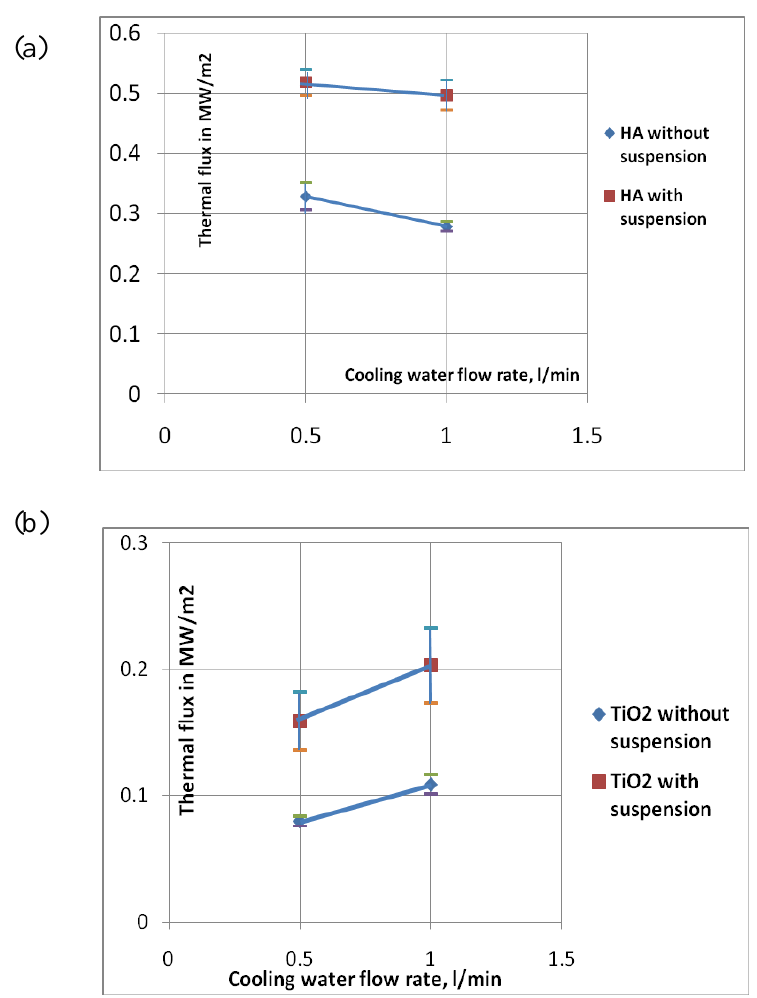
Figure 6. Thermal fluxes heating copper head vs. cooling water flow rates measured during calorimetric measurements simulating deposition of HA coatings (a), and TiO coatings